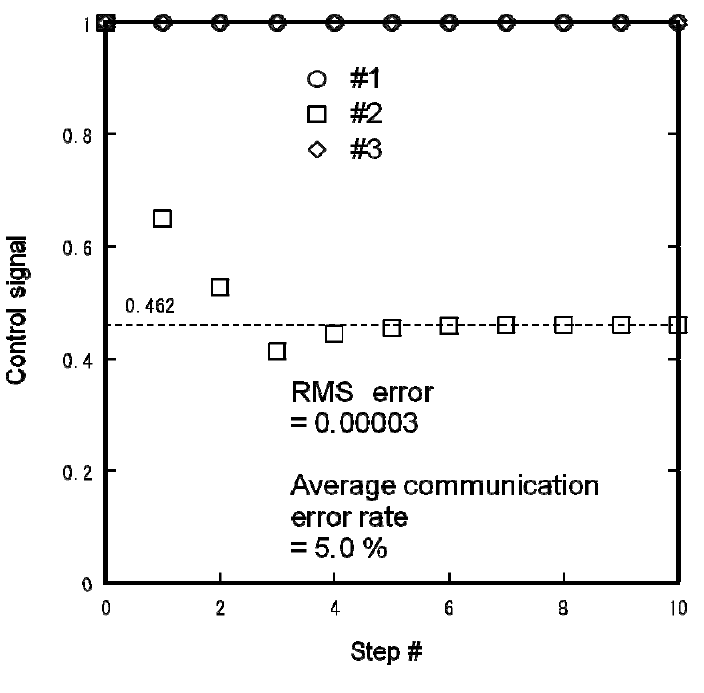
Figure 15. Experimental distributed lighting result obtained using Mote testbed for { s , s , s } = {1,0,1}. 1 2 3